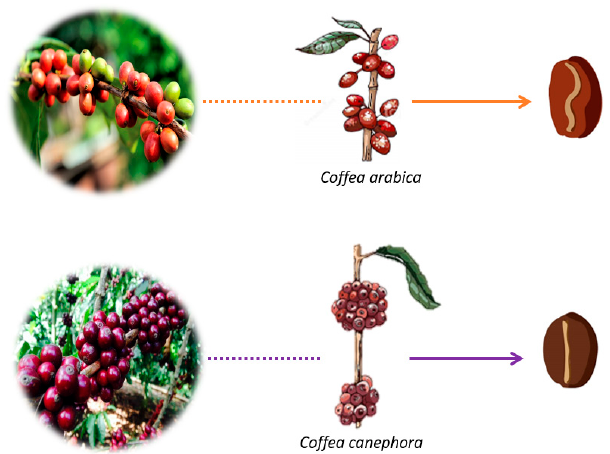
Figure 2. The two most traded co ff ee species in the world